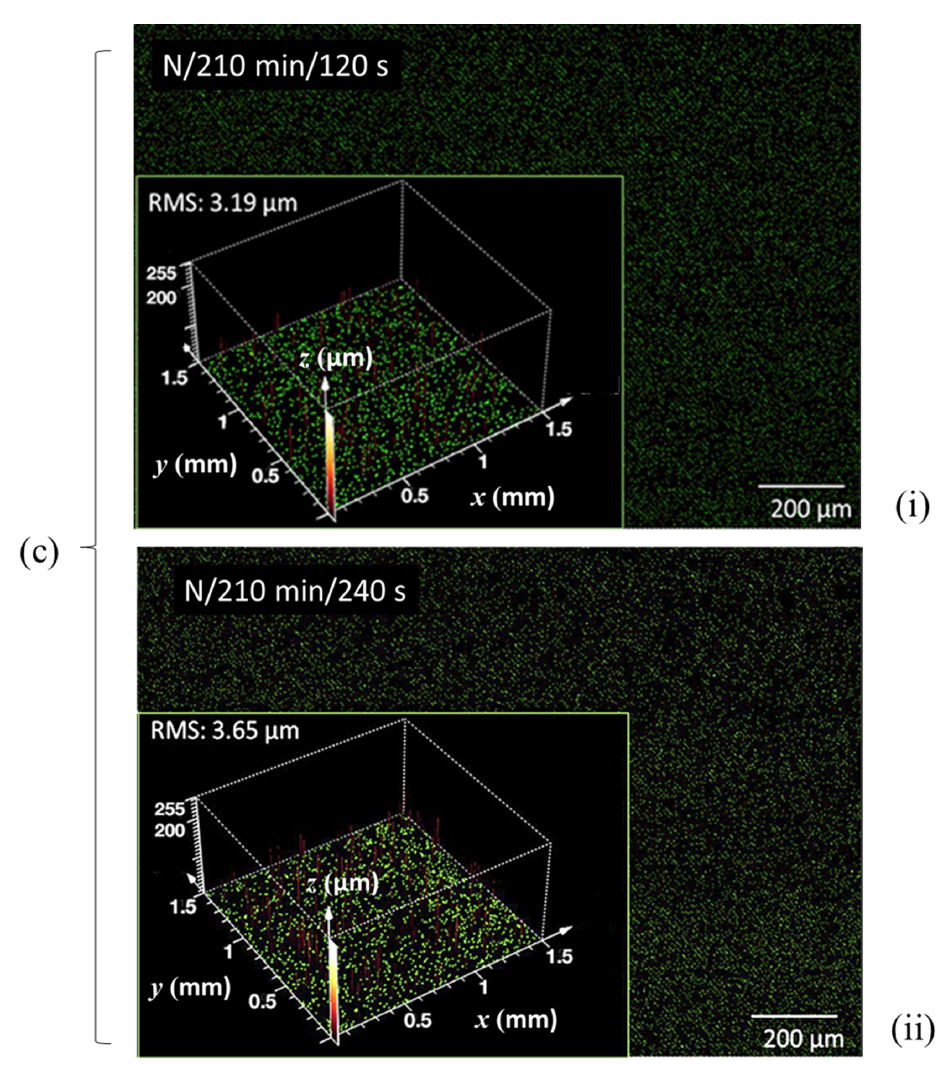
Figure 9. CLSM surface profile plots, showing the microscan as background and contour height spatial distribution in the insert, comparing the effect of enzymatic pretreatment time ( a ) 0 min, ( b ) 60 min, and ( c ) 210 min, producing smoother films before plasma exposure, to the slight roughening effect of N plasma exposure time ( i ) 120 s, and ( ii ) 240 s.